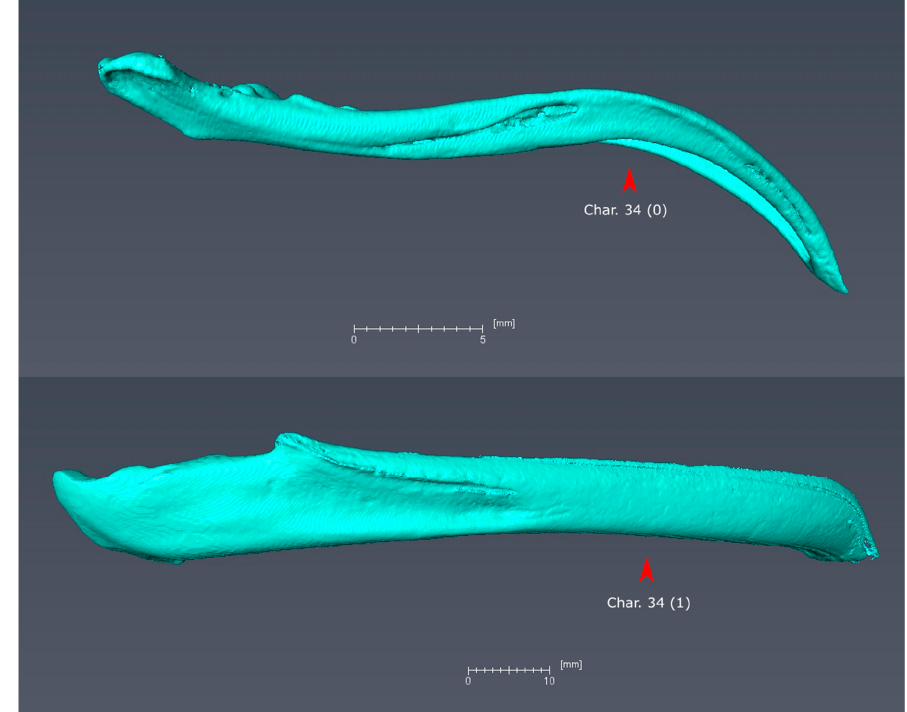
Figure A6. Mandibles of Streptoprocne zonaris (top) and Podargus (bottom) in right lateral view. Streptoprocne exhibits state 0 for character 34 (ventral margin of mandibular rami decurved in lateral view), whereas Podargus exhibits state 1 (ventral margin of mandibular rami virtually straight in lateral view, optimized as a synapomorphy of Podargiformes). Diversity 2019 , 11 , x